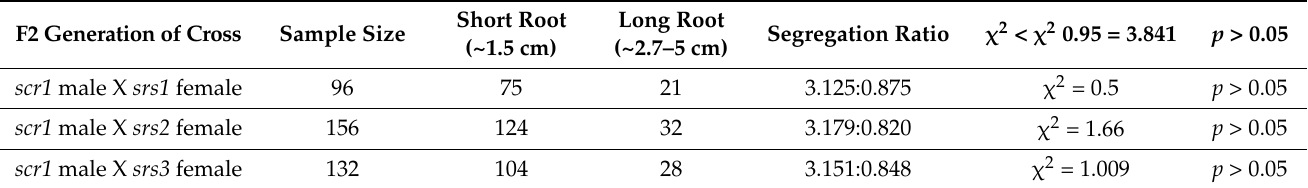
Table 2. Backcross of A. thaliana scr root length suppressors with scr1 . F2 generation progeny of scr1 X srs suppressors were analyzed to test short root/long root ratio. χ 2 < 3.84 is nonsignificant at 0.05 probability level.